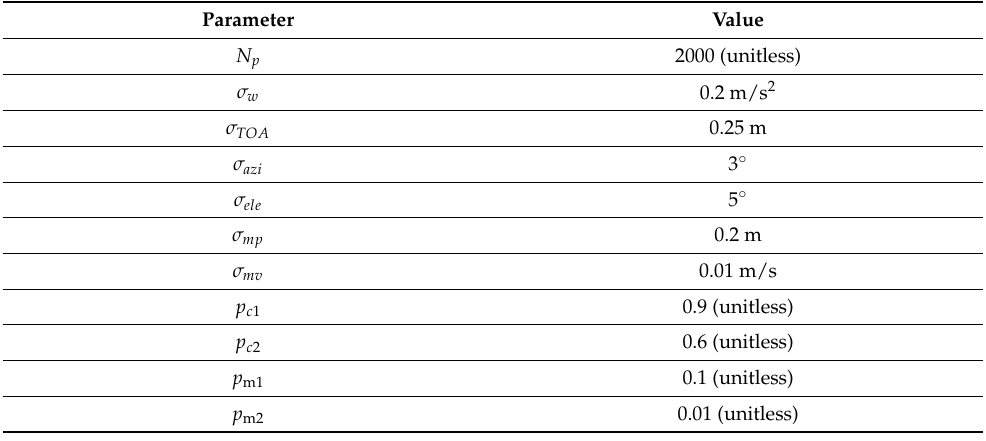
Table 3. The parameters used in Test